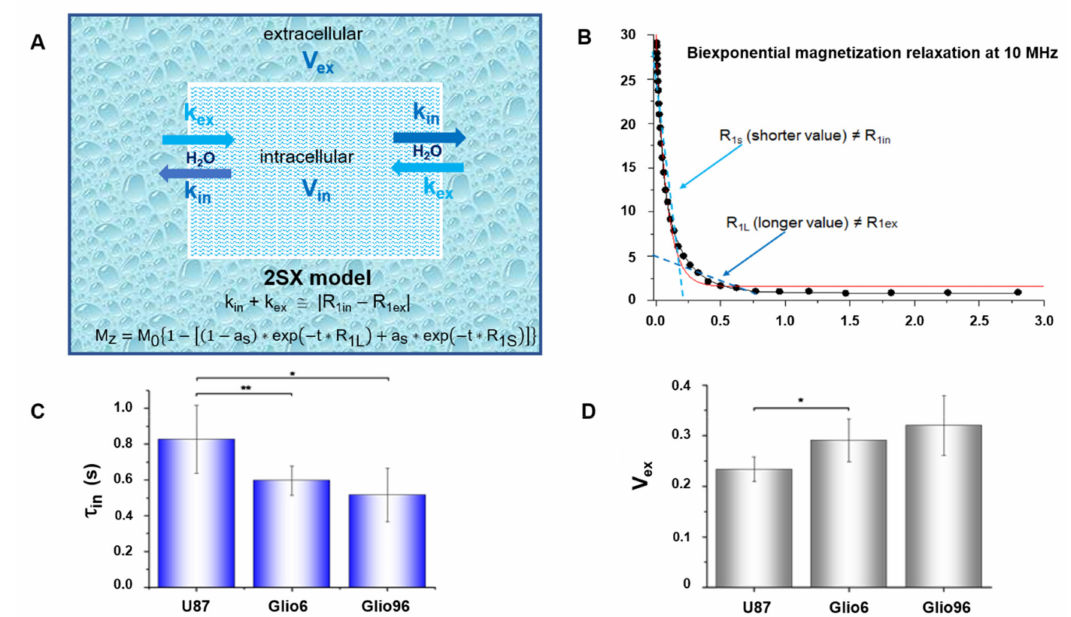
Figure 5. ( A ): Scheme and equations of the 2SX transmembrane water exchange model. ( B ): Typical bi- exponential of short (R 1S ) and long relaxation (R 1L ) of glioma tissue in vivo (case of Glio6 acquired at 10 MHz). Red and black continuous lines correspond to mono-exponential and bi-exponential fitting, respectively. ( C ): Mean values of the intracellular water lifetime ( τ in ) of the three glioma models, showing rapid water exchanges in case of invasion (Glio6 and Glio96). ( D ): Mean extracellular volumes (V ex ). Larger V ex are detected in the case of invasion (Glio6 and Glio96). Data are reported as mean ± SD (* p < 0.05, ** p <